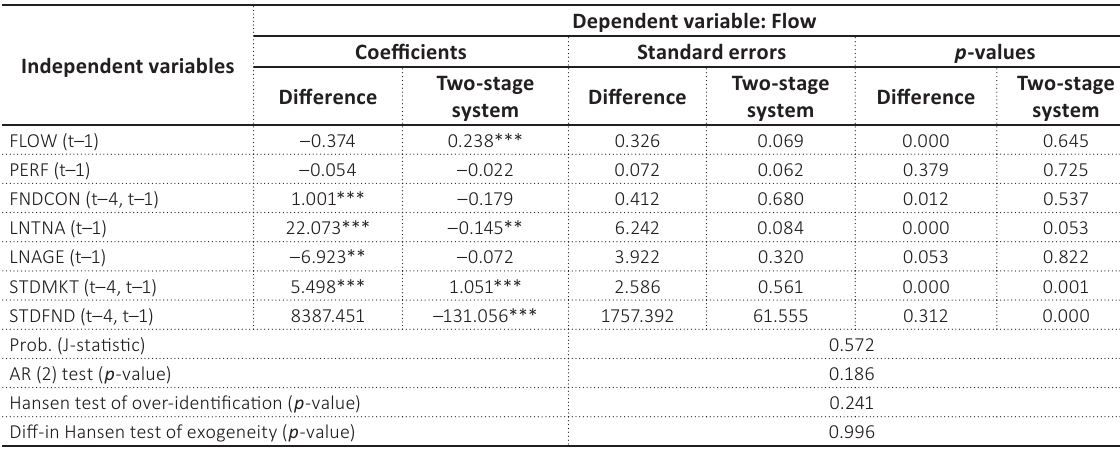
Source: Authors’ estimations